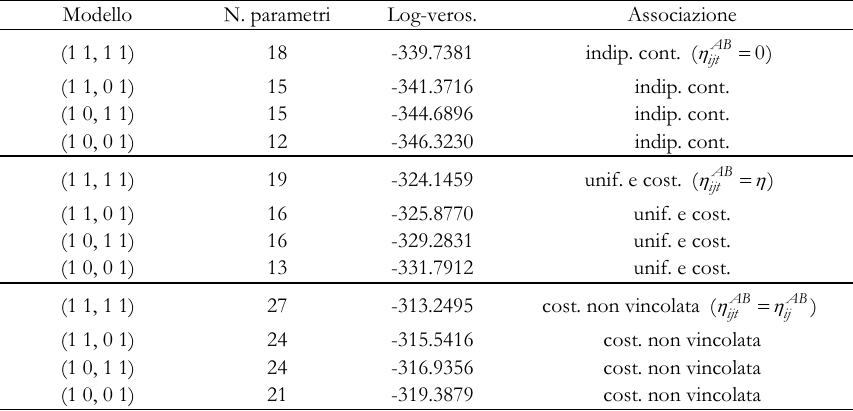
fluenza di sui logit delle probabilità di transizione marginali della mutabile B t